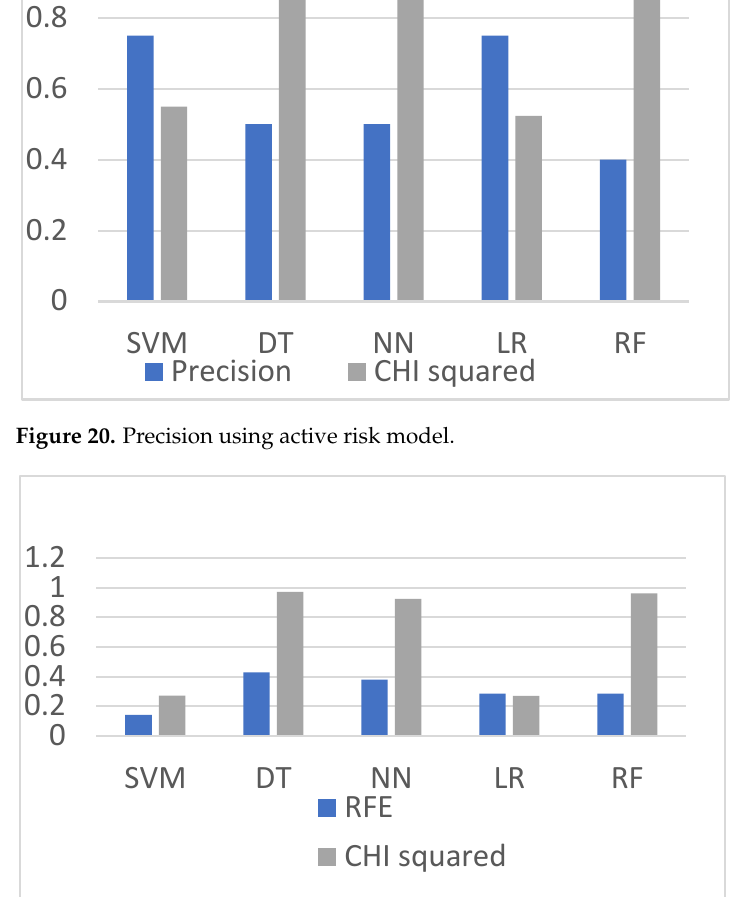
Figure 21. Recall using active risk model.